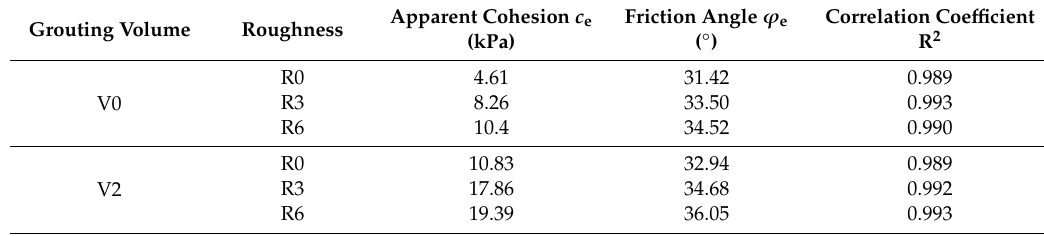
Figure 8. Fitted curves between peak shear stress and normal stress with different roughness values in different grouting cases: ( a ) V0 and ( b ) V2. Table 5. Fitted curve parameters (interfacial apparent cohesion and friction angle) conforming to Mohr–Coulomb shear criterion for specimens with different roughness values